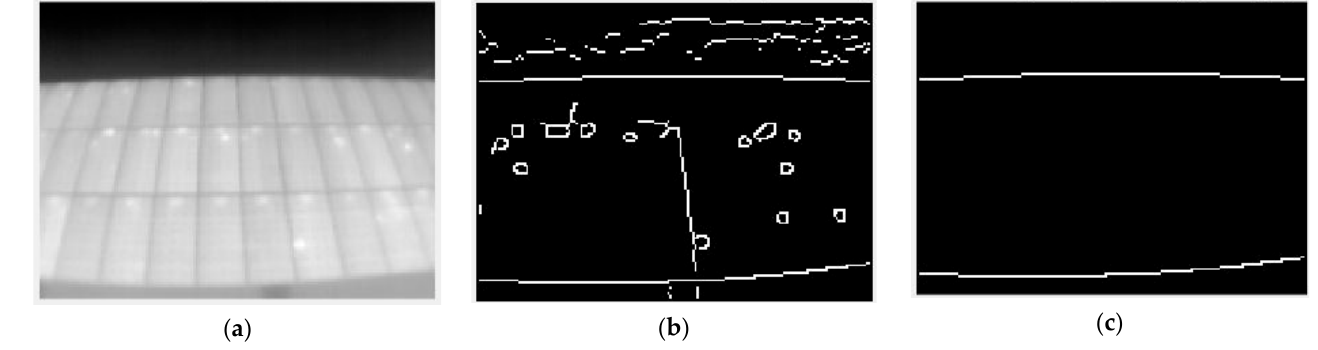
Figure 5. Result of removing small objects applied to the result of the “canny” filter. ( a ) Raw image; ( b ) Edge detection with Canny filter; and ( c ) Small objects removing.